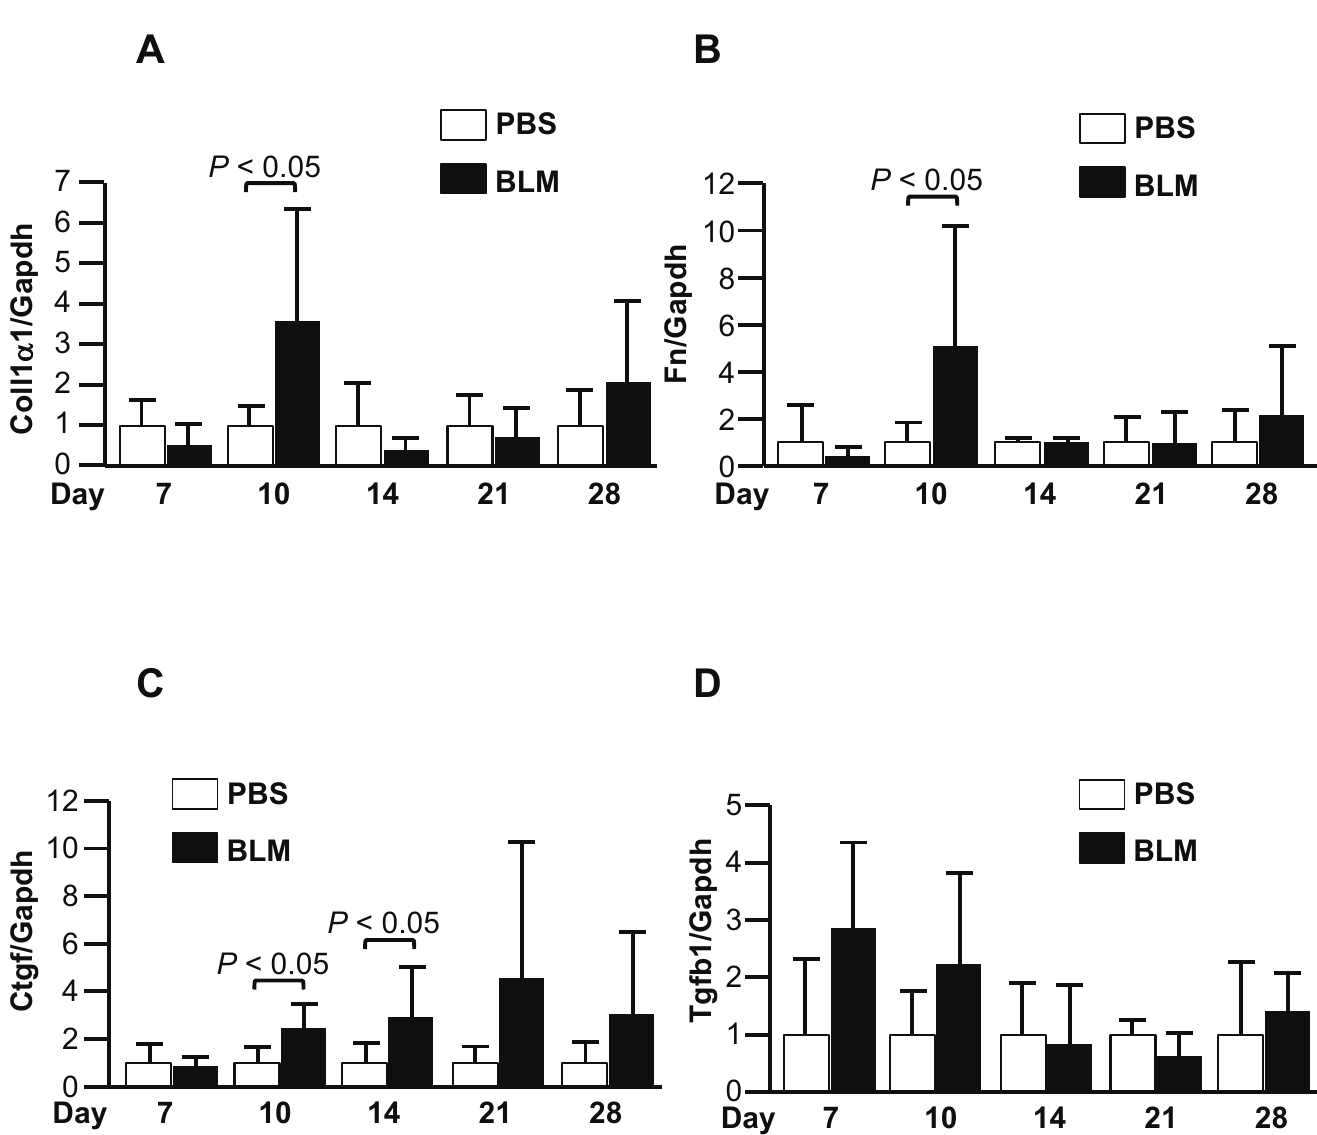
Fig 4. Expression levels of fibrosis-related genes. Mice treated with BLM (60 U/kg) were sacrificedon days 7, 10, 14, 21, and 28. Expression levels of fibrosis-related geneswere measuredin skin tissues on the indicateddays. (A) Coll1 α 1mRNA levels. (B) FibronectinmRNA levels. (C) Ctgf mRNA levels. (D) Tgfb1 mRNA